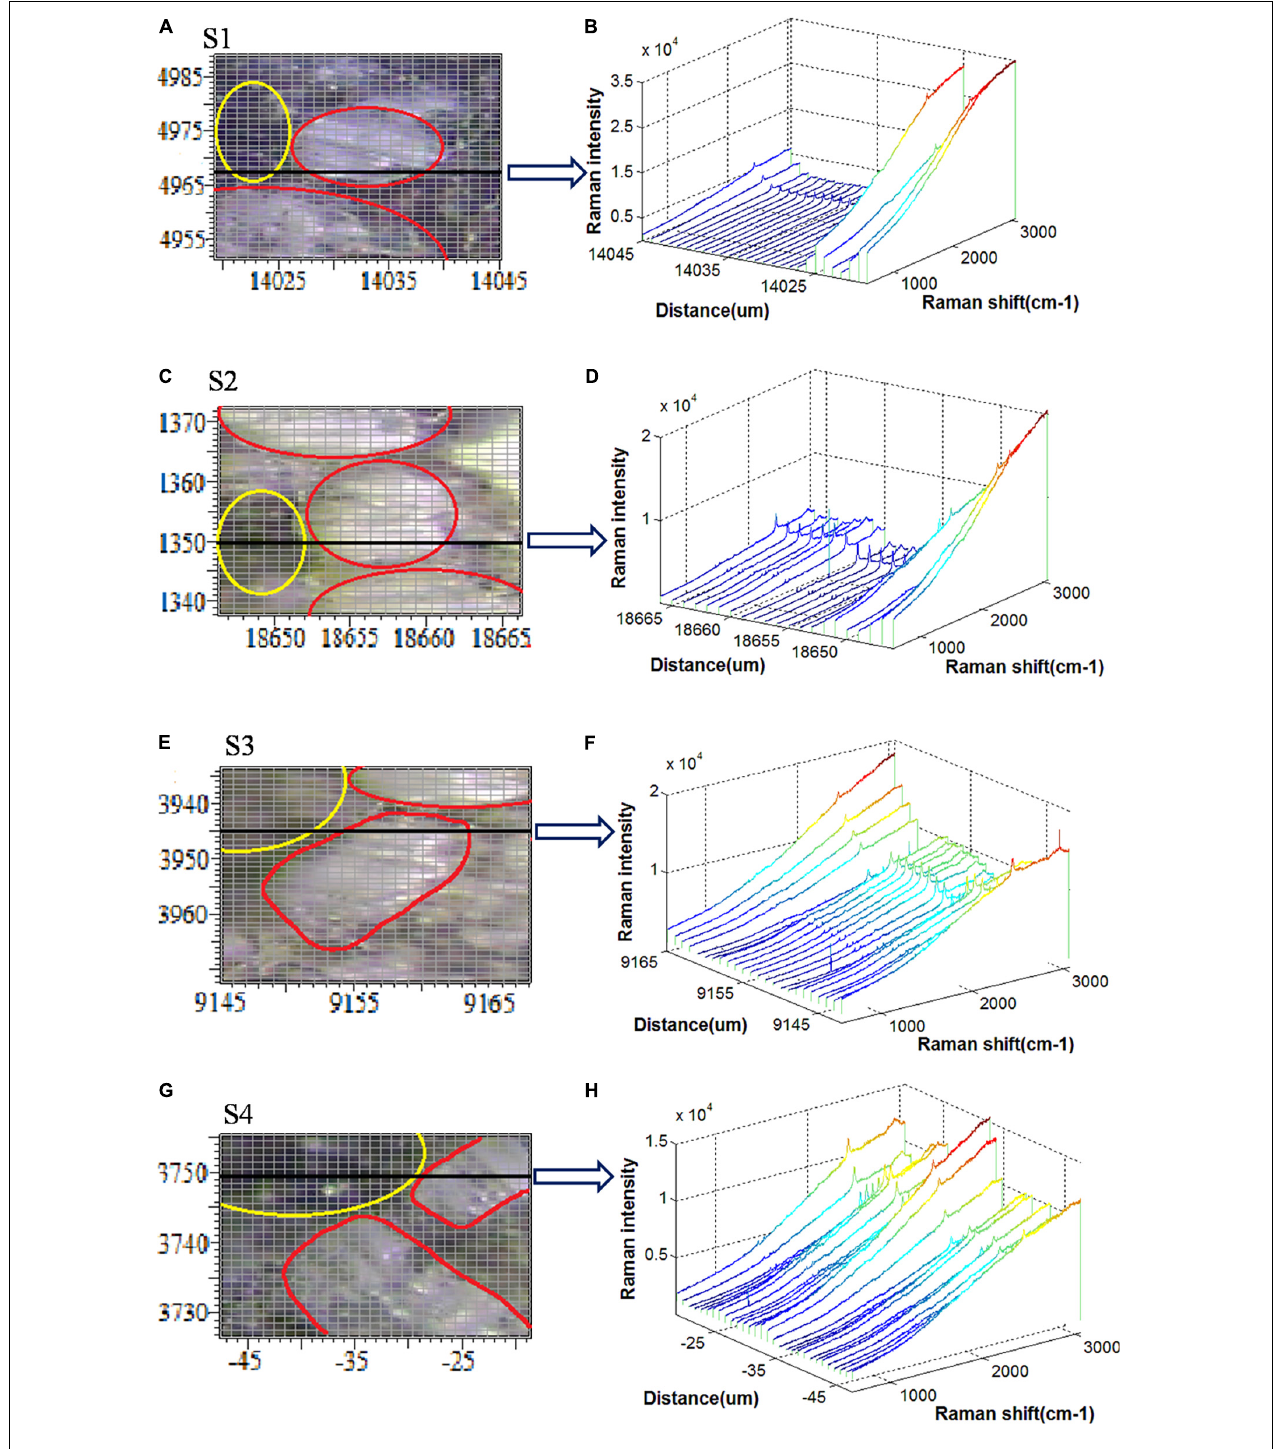
FIGURE 3 | Raman spectral scanning regions and spectral responses for (A,B) S1, (C,D) S2, (E,F) S3, and (G,H) S4.